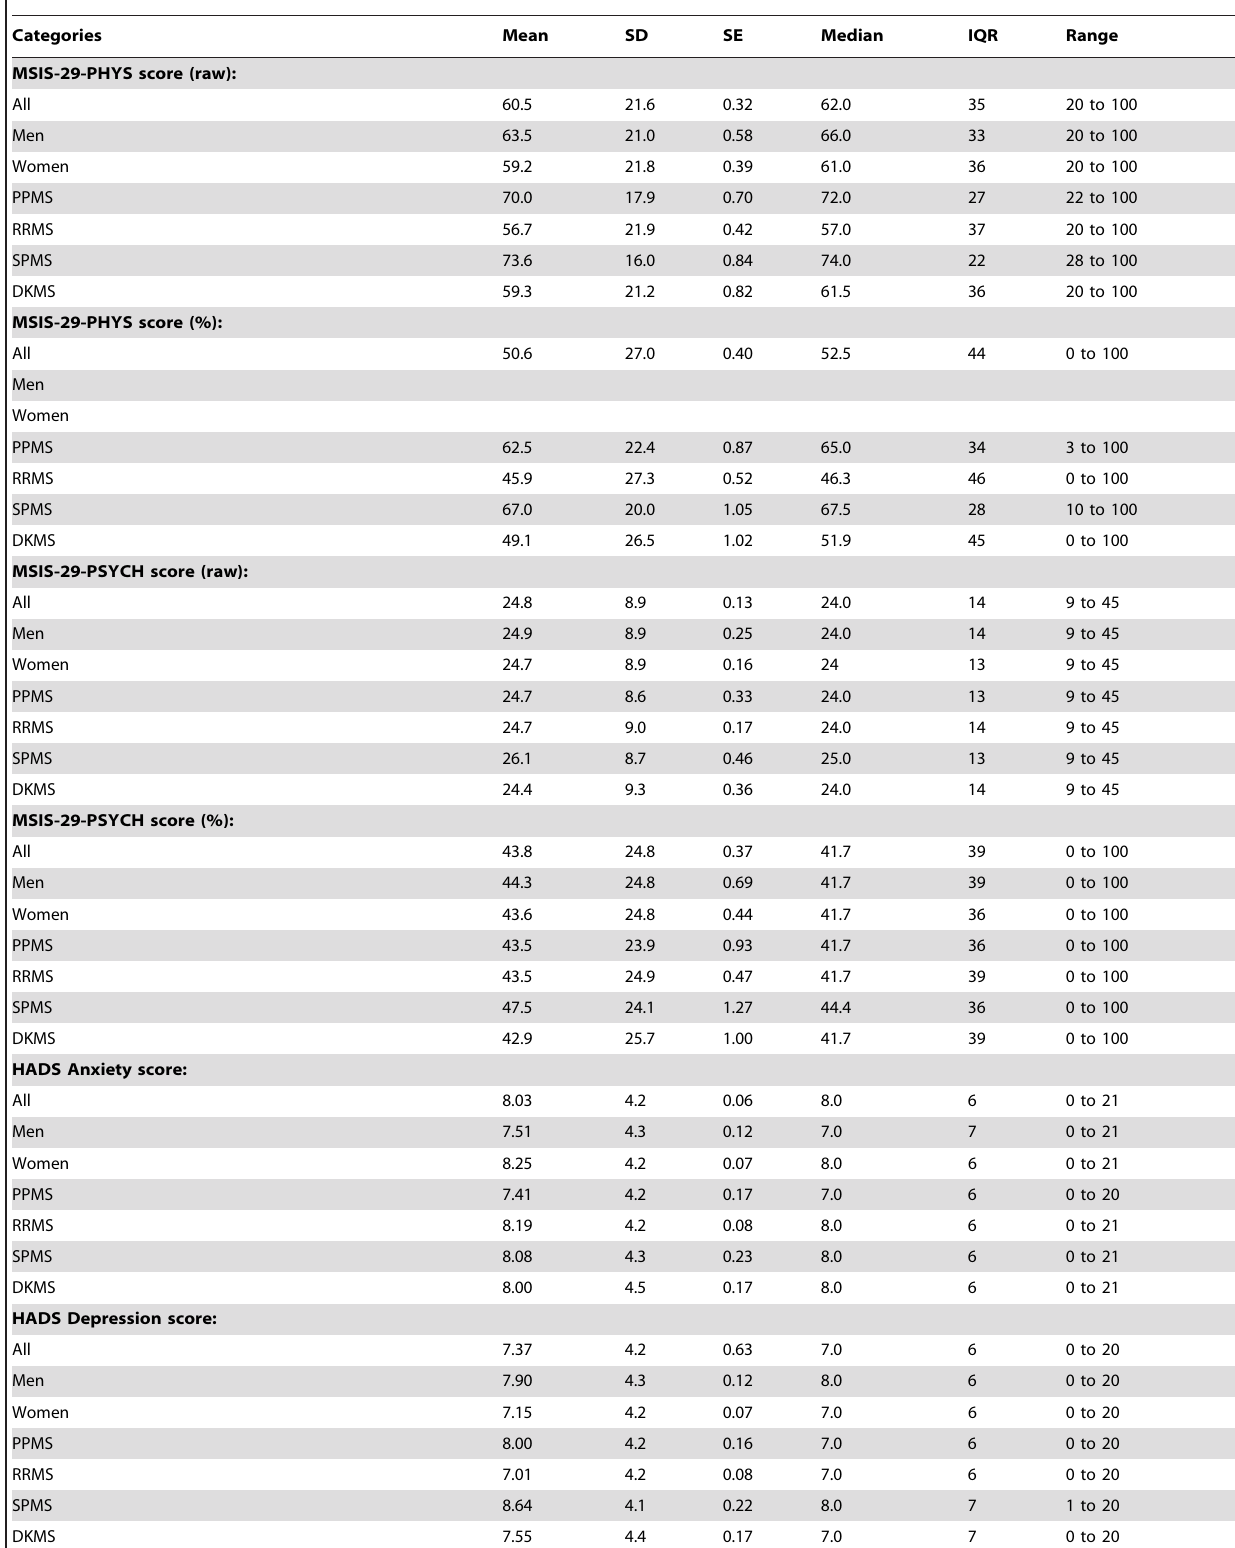
Table 1. The MSIS-29 and HADS scores of the